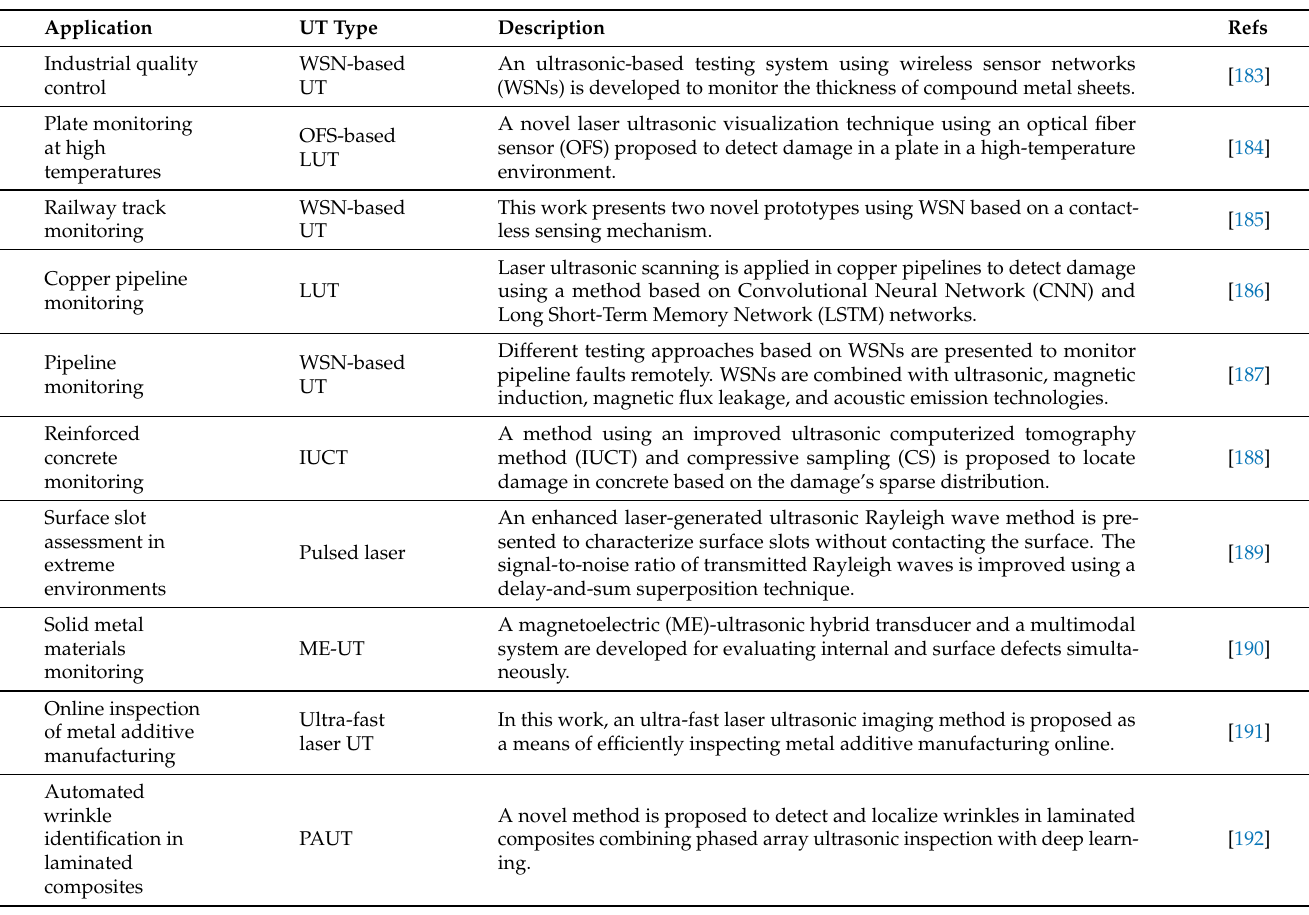
Table 9. Recent papers using advanced ultrasonic